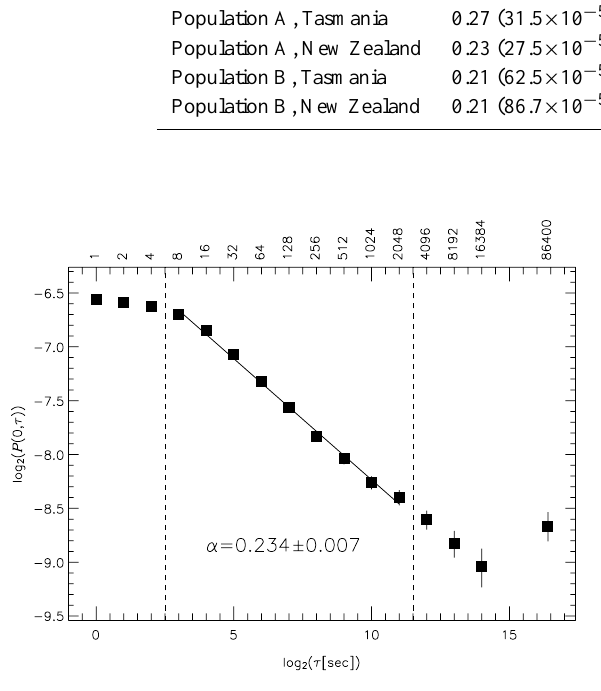
Fig. 5. Scaling of the PDF peaks, log 2 P (0, τ ) versus log 2 τ for the δ v los curves shown in Fig. 4. The linear best fit to the data yields a slope of α Peak =0.234 ± 0.007 using a PDF bin size of 1ms − 1 . The error bars assume Gaussian noise in the peaks, and are drawn at the 3 σ level. The vertical dashed line indicates the nominal outer temporal scale for the power law regime.